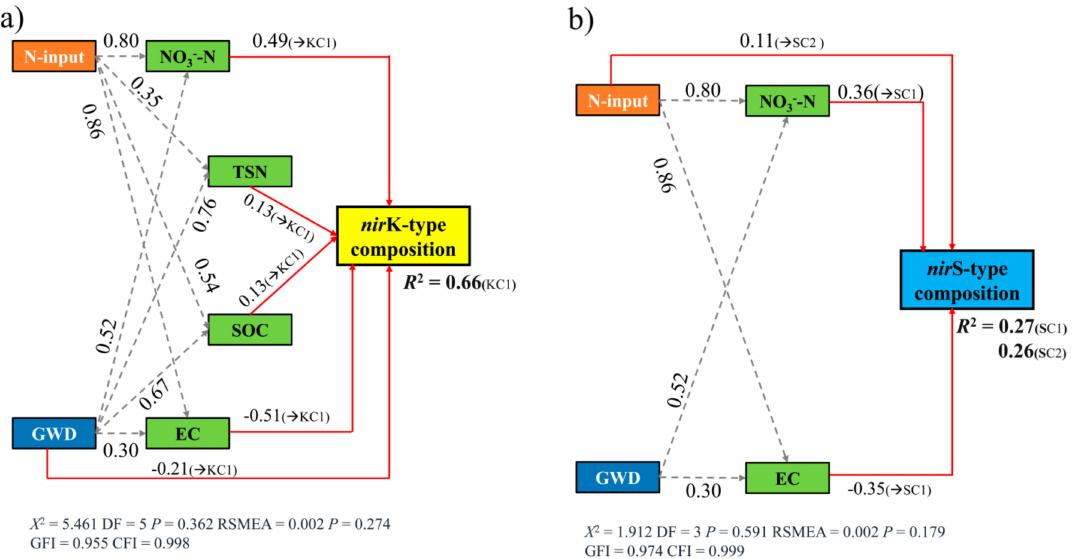
Figure 5. SEM describing the direct and indirect e ff ects of depression of groundwater table, reduced nitrogen application and soil attributes on the species composition (two axes from nonmetric multidimensional scaling) of nir K ( a ) and nir S genes ( b ). The solid red arrows indicate the significant direct paths ( P < 0.05), and the dashed grey arrows represent the significant indirect paths ( P < 0.05). N-input, reduced nitrogen application; GWD, groundwater table condition treatments; KC1, NMDS1 for nir K genes; SC1 and SC2, NMDS1 and NMDS2 for nir S